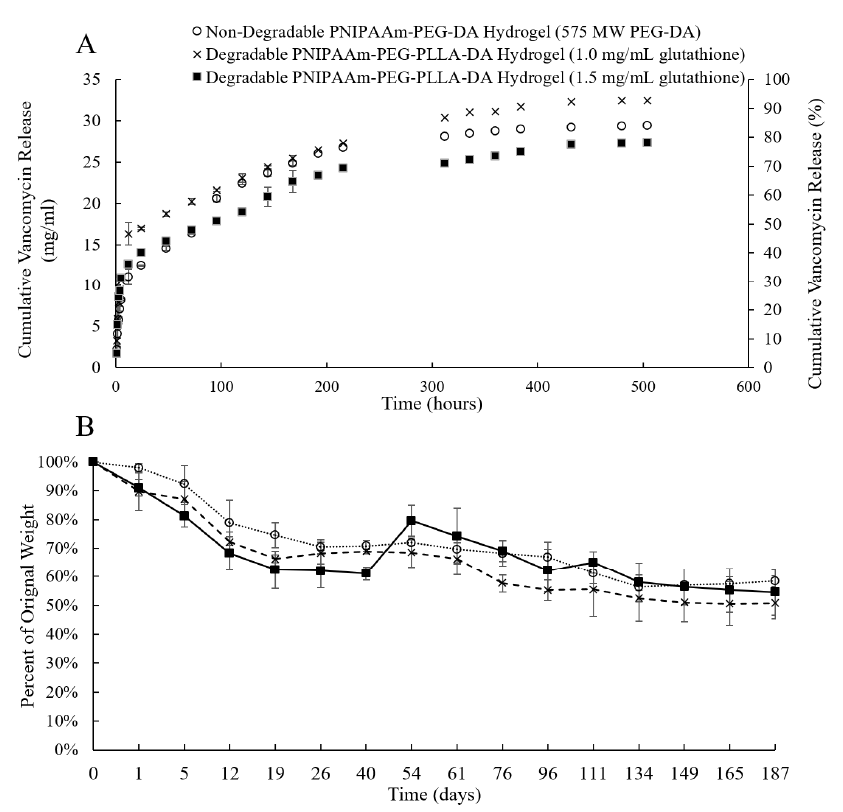
Figure 2. The effects of glutathione on release and degradation of 1 mL thermo-responsive PNIPAAm- PEG-DA hydrogel DDS. ( A ) Release from a 1 mL thermo-responsive PNIPAAm-PEG-DA-based hydrogel and hydrogels containing PEG-PLLA-DA and 1.0 and 1.5 mg/mL glutathione, respectively. Non-degradable hydrogels showed a significantly lower ( p < 0.05) initial burst than both biodegrad- able hydrogels at 5, 12 and 24 h. ( B ) Hydrogel degradation over time for the non-degradable, 1.0 mg/mL and 1.5 mg/mL hydrogels over 187 days.